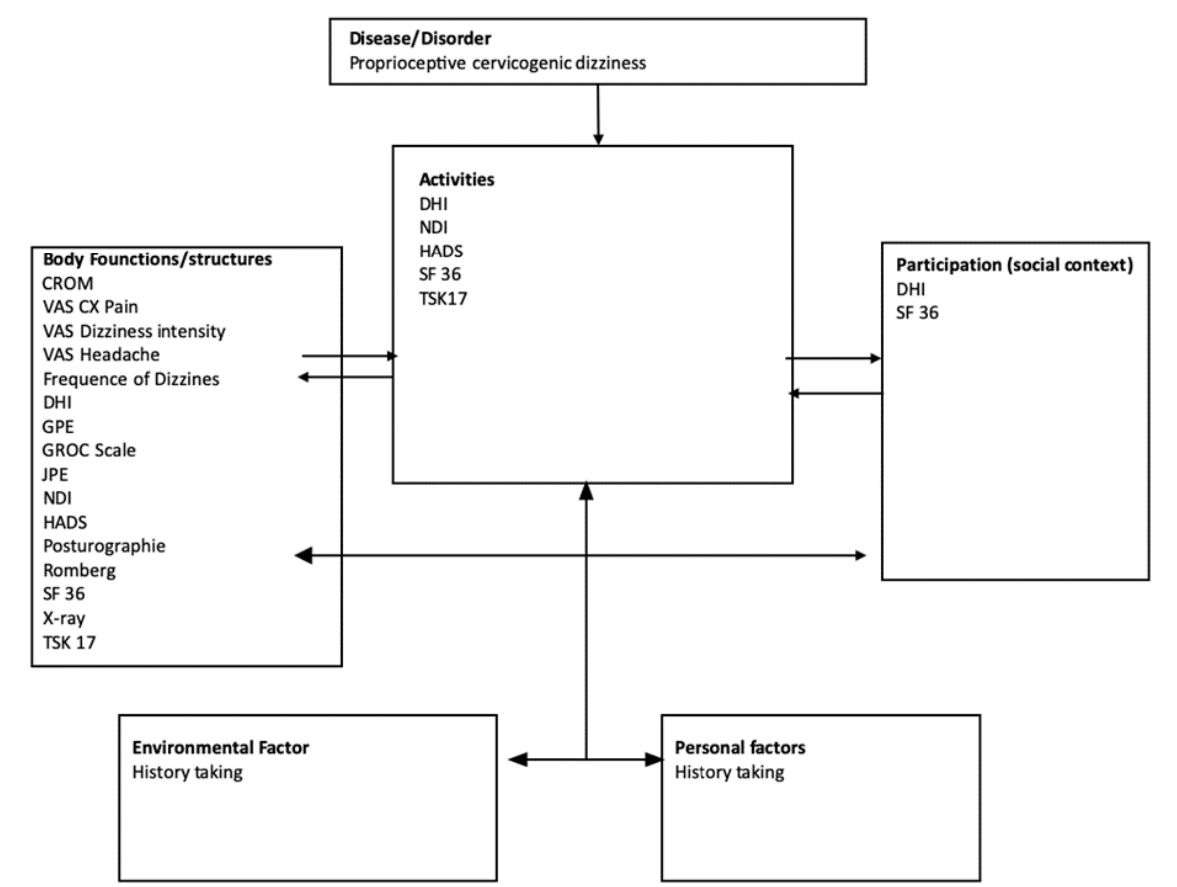
Figure 9. Measurement instruments in proprioceptive cervicogenic dizziness: an ICF classification (some measurement instruments are suitable in more than one ICF component). CROM: cervical range of motion, DHI: dizziness handicap inventory, GPE: global perceived effect, GROC-scale: global rating of change, HADS: Hospital Anxiety and Depression Scale, JPE: joint position error test, NDI: neck disability index, HRQoL: health-related quality of life, TSK: Tampa Scale for Kinesiophobia, VAS: visual analog scale.